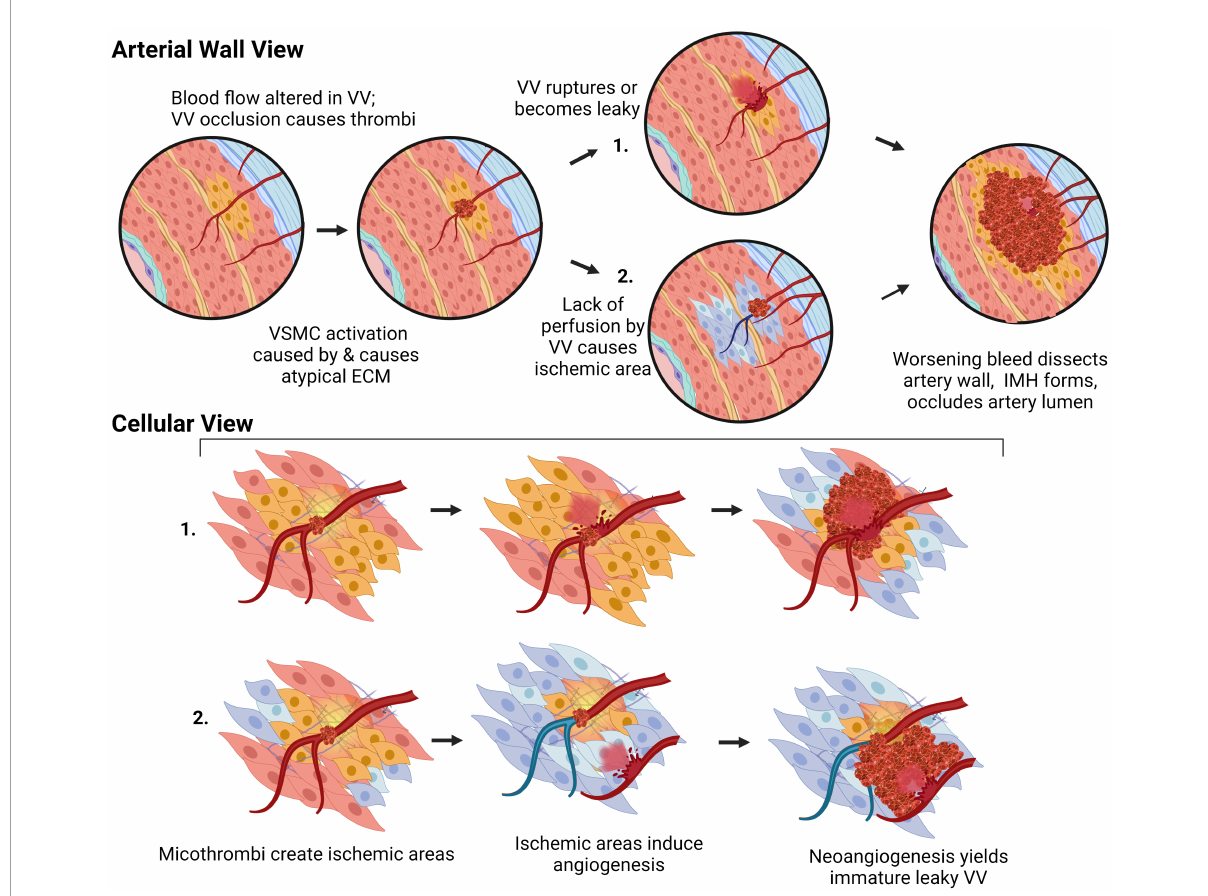
FIGURE7 Proposed mechanism for arterial dissections. Atypical ECM deposition, activation of VSMC or EC will perturb vasa vasorum (VV) blood flow, leading to either their spontaneous rupture, or an area of ischemia encouraging growth of immature leaky vessels prone to bleed and, thus the development of an intramural hematoma, which impairs luminal blood flow resulting in tissue ischemia and/or infarction. Created with